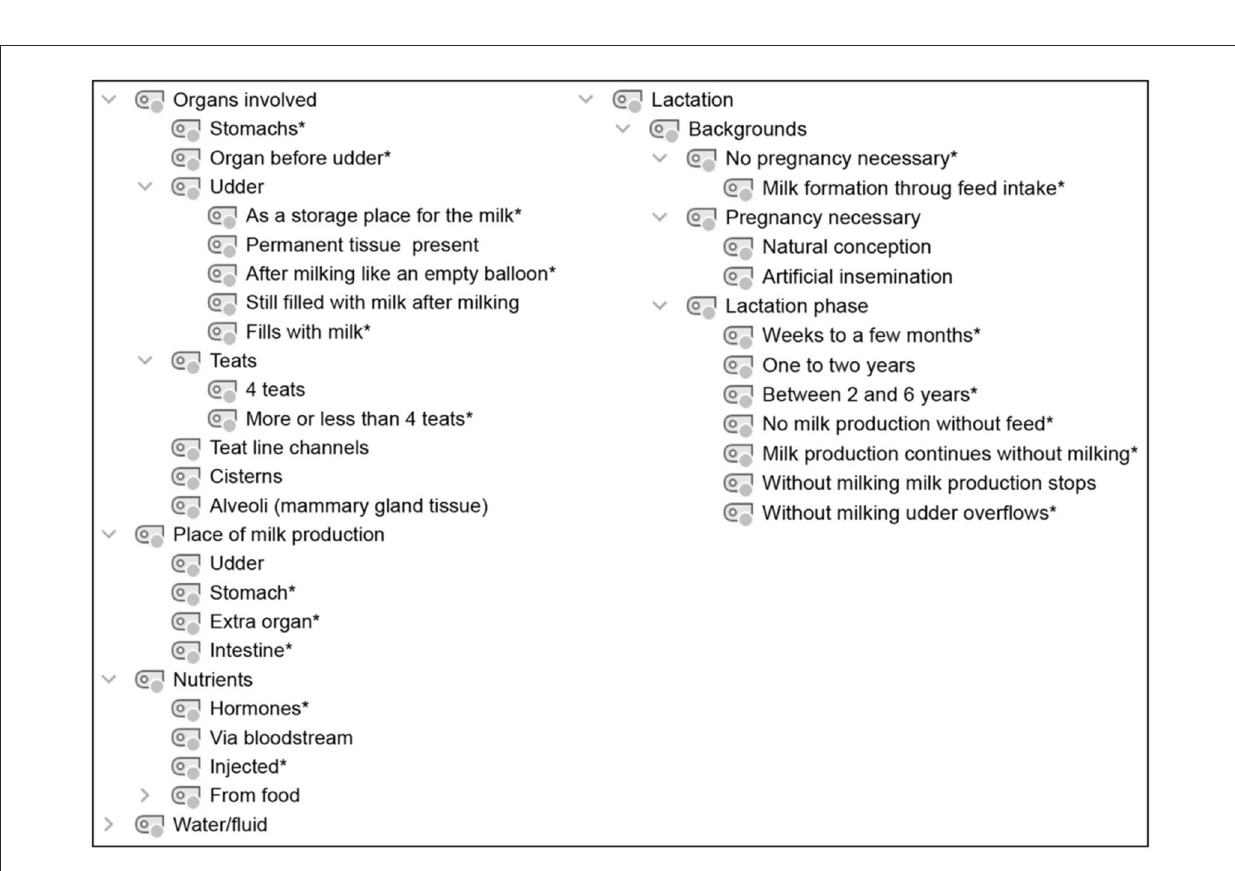
FIGURE3 Category system for analyzing student conceptions of lactation. *Inductively coded